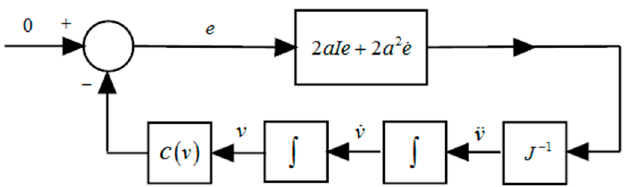
Figure 5. Control scheme to determine ˆ v .